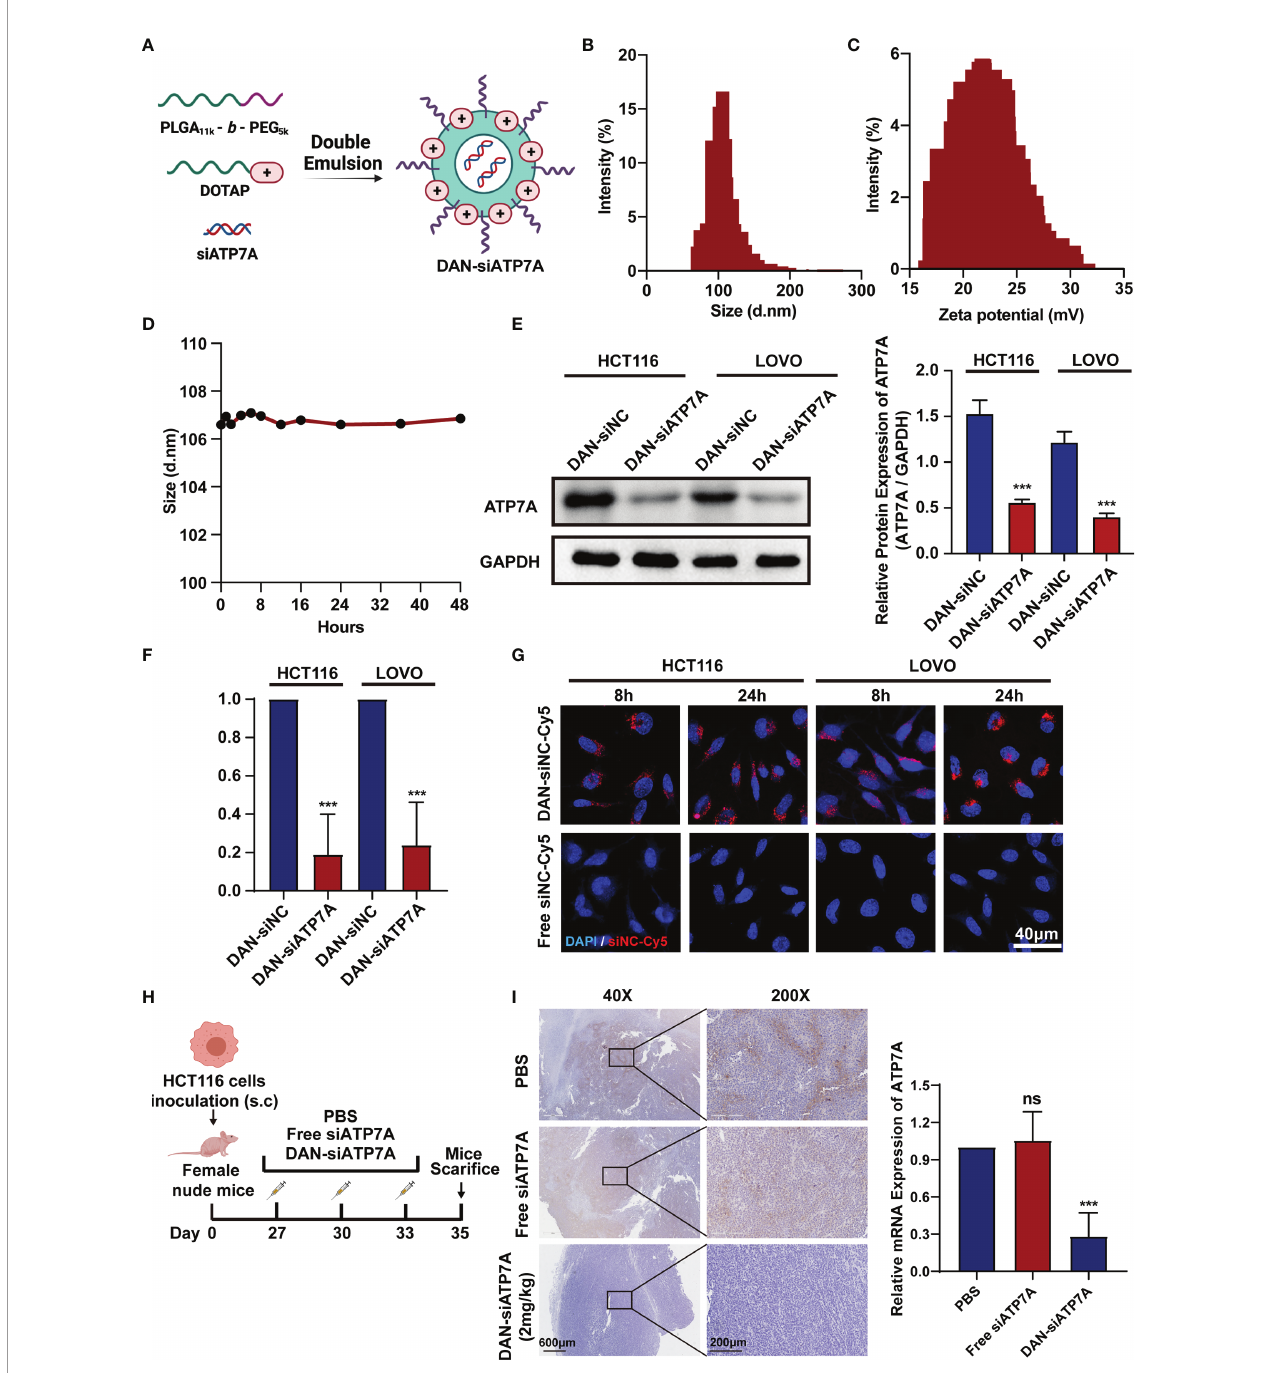
FIGURE 4 | Construction of DAN nanoparticle. (A) The schematic illustration of the nanoparticle DAN-siATP7A construction. The size (B) and zeta potential (C) distribution of DAN-siATP7A. (D) The size measurement of DANsiATP7A in the RPMI-1640 supplemented with 10% FBS. The protein expression (E) and mRNA expression (F) of ATP7A after being transfected with DAN-siATP7A in HCT116 and LOVO cell lines. (G) The in Virto cellular uptake of Cy5-labeled DAN-siNC and free Cy5-labeled siNC in vitro . The confocal image was captured 8 hours and 24hours after the transfection of HCT116 and LOVO cell lines. (H) The scheme of medication on tumor-bearing mice. (I) The IHC analysis of ATP7A and the PCR analysis of ATP7A mRNA in tumor tissue implied effective knockdown of ATP7A via DAN-siATP7A nanoparticles. ***P < 0.001 and ns, not signi fi cance, when compared to the control